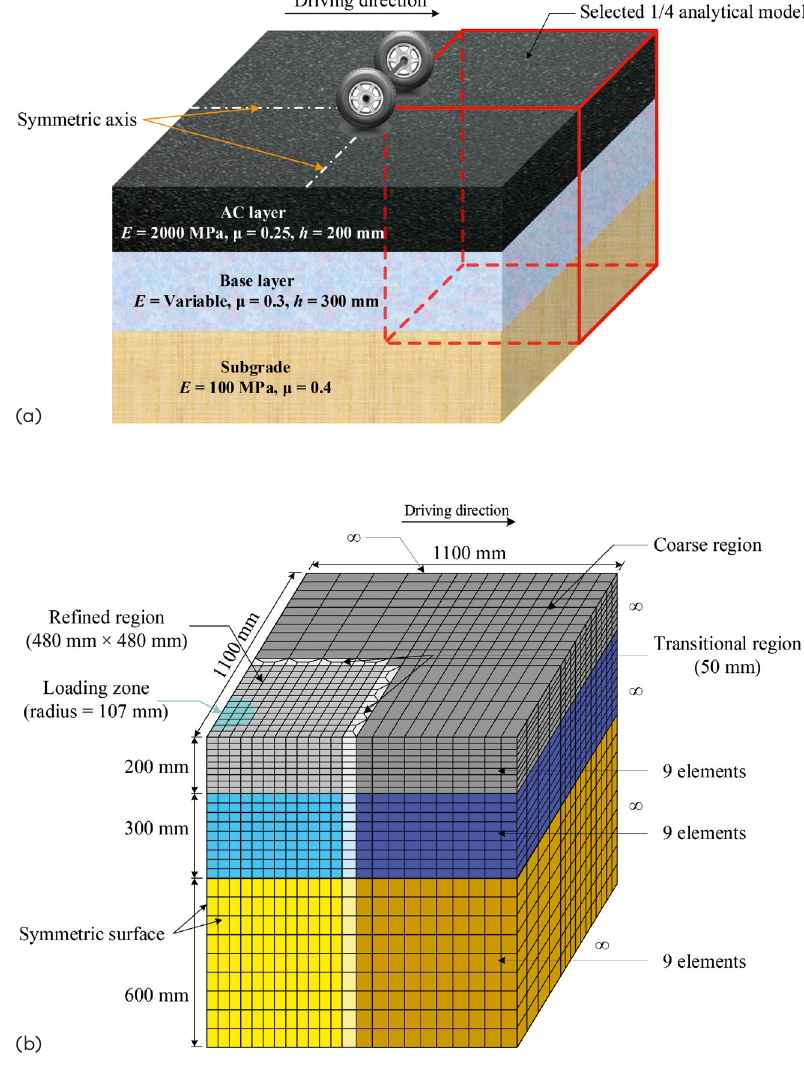
Figure 2. The finite element model: (a) selected 1/4 model, (b) geometric dimensions and